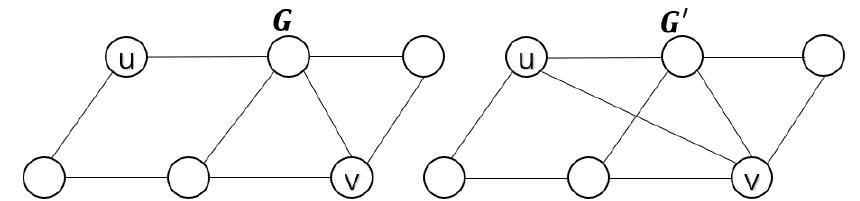
Figure 8. G (cid:48) is obtained from G by adding the edge ( u , v )